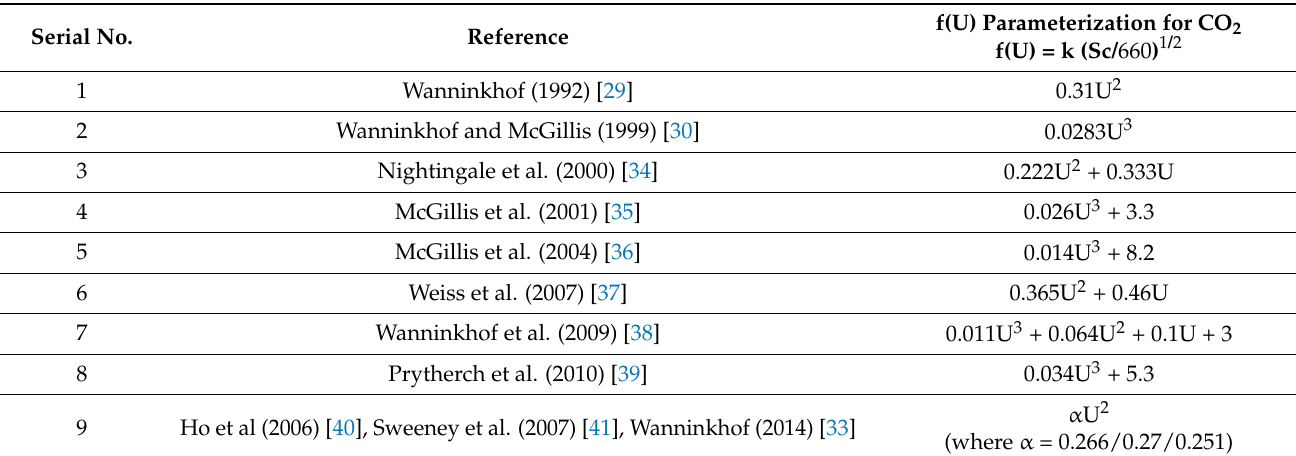
Table 1. The f(U) parameterizations used in estimating gas transfer velocity for CO 2 (same expressions can be used for other slightly soluble gases [33]). The f(U) formulations developed from long-term wind speeds (i.e., monthly) were not considered here. In Serial No.9, because the three equations are identical in form with a small difference in their α coefficients, we use the expression f(U) = 0.251 U 2 [25] in the following analysis as a representative equation of all three models.